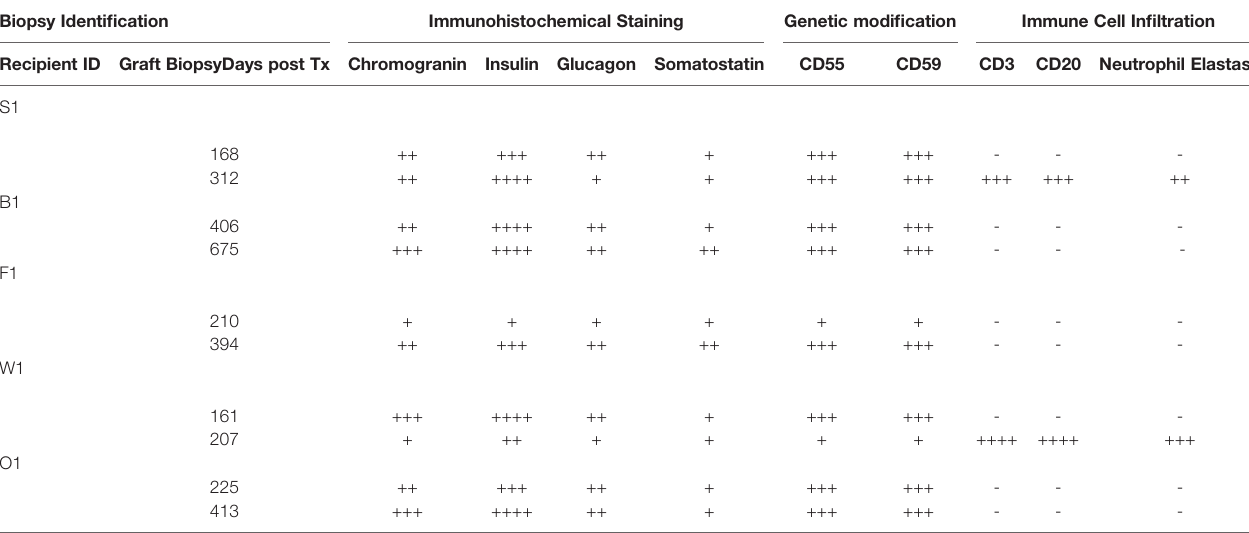
TABLE 2 | An overview of histopathological outcomes in relation to the recipients clinical course.